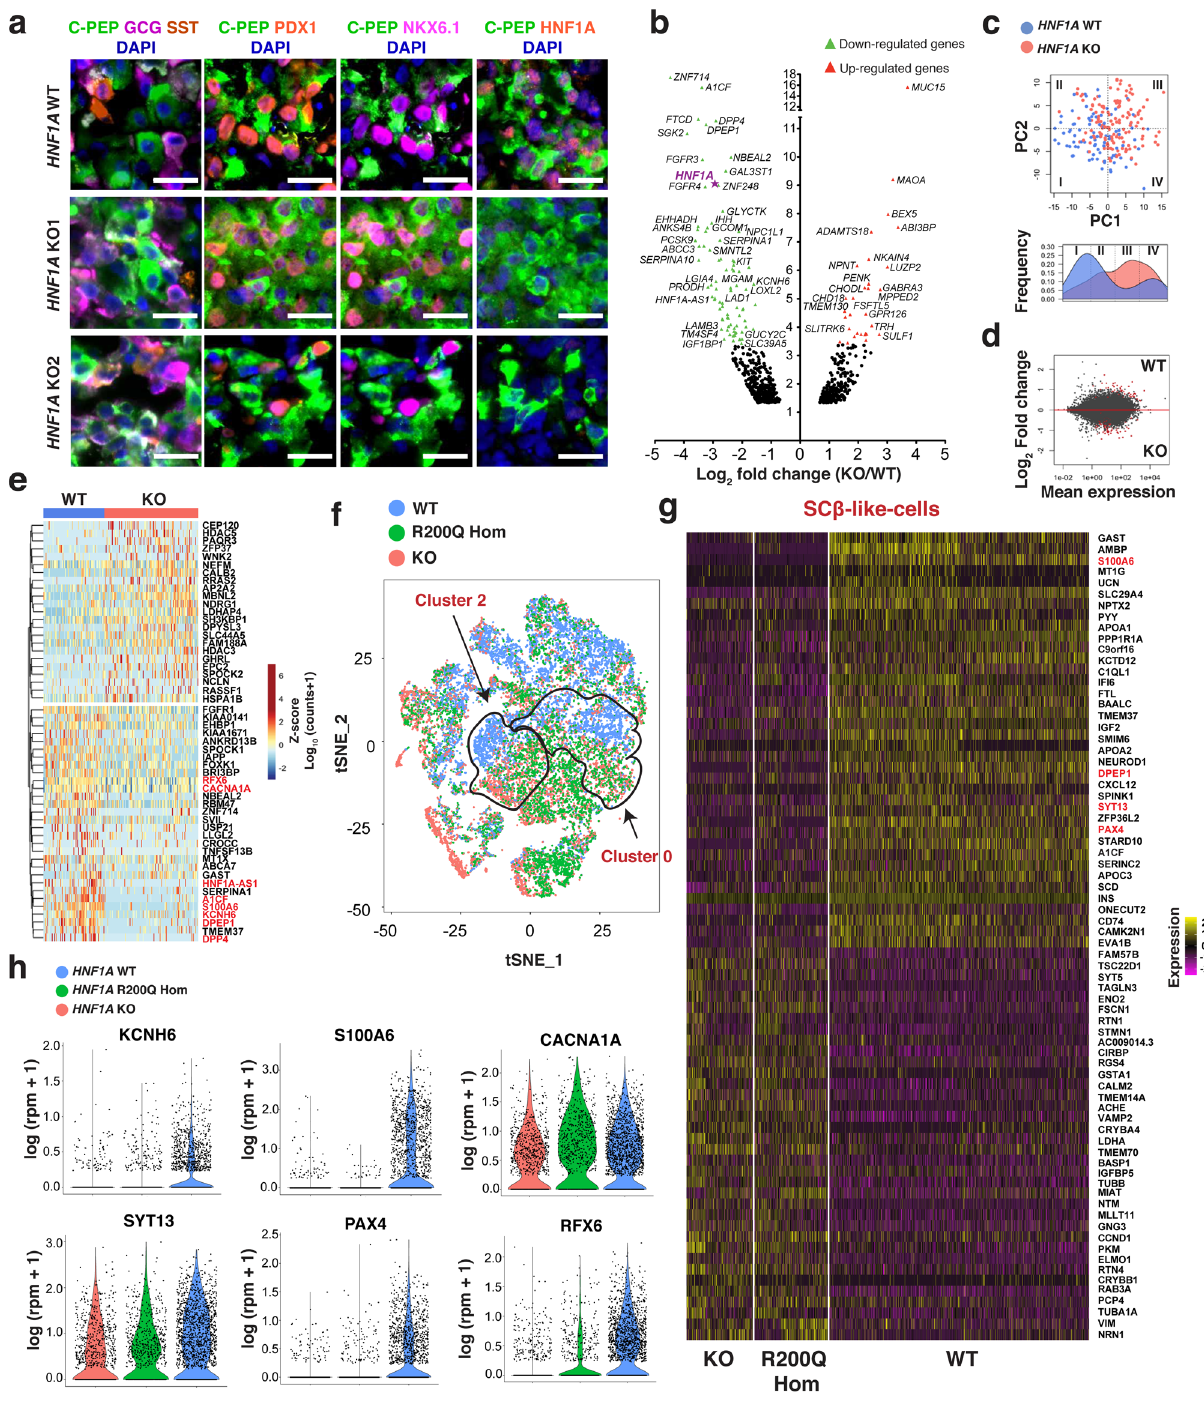
HNF1A KO and WT lines in vitro. Volcano plot analysis of bulk RNA sequencing identi fi ed 30 up-regulated genes and 148 down- regulated genes in HNF1A KO β -like cells (Fig. 1b and Supple- mentary Data 3). Single-cell RNA sequencing showed that HNF1A KO β -like cells segregated from HNF1A WT β -like cells based on their gene expression pro fi le by principal component analysis (Fig. 1c), and volcano plot analysis (Fig. 1d) revealed previously undescribed HNF1A target genes involved in intracellular calcium signaling ( CACNA1A , S100A6, and TMEM37 ), calcium-mediated insulin secretion ( KCNH6 ) and glucose-stimulated insulin secre- tion ( RFX6 , DPEP1 , DPP4, and IAPP ) (Fig. 1e) as commonly